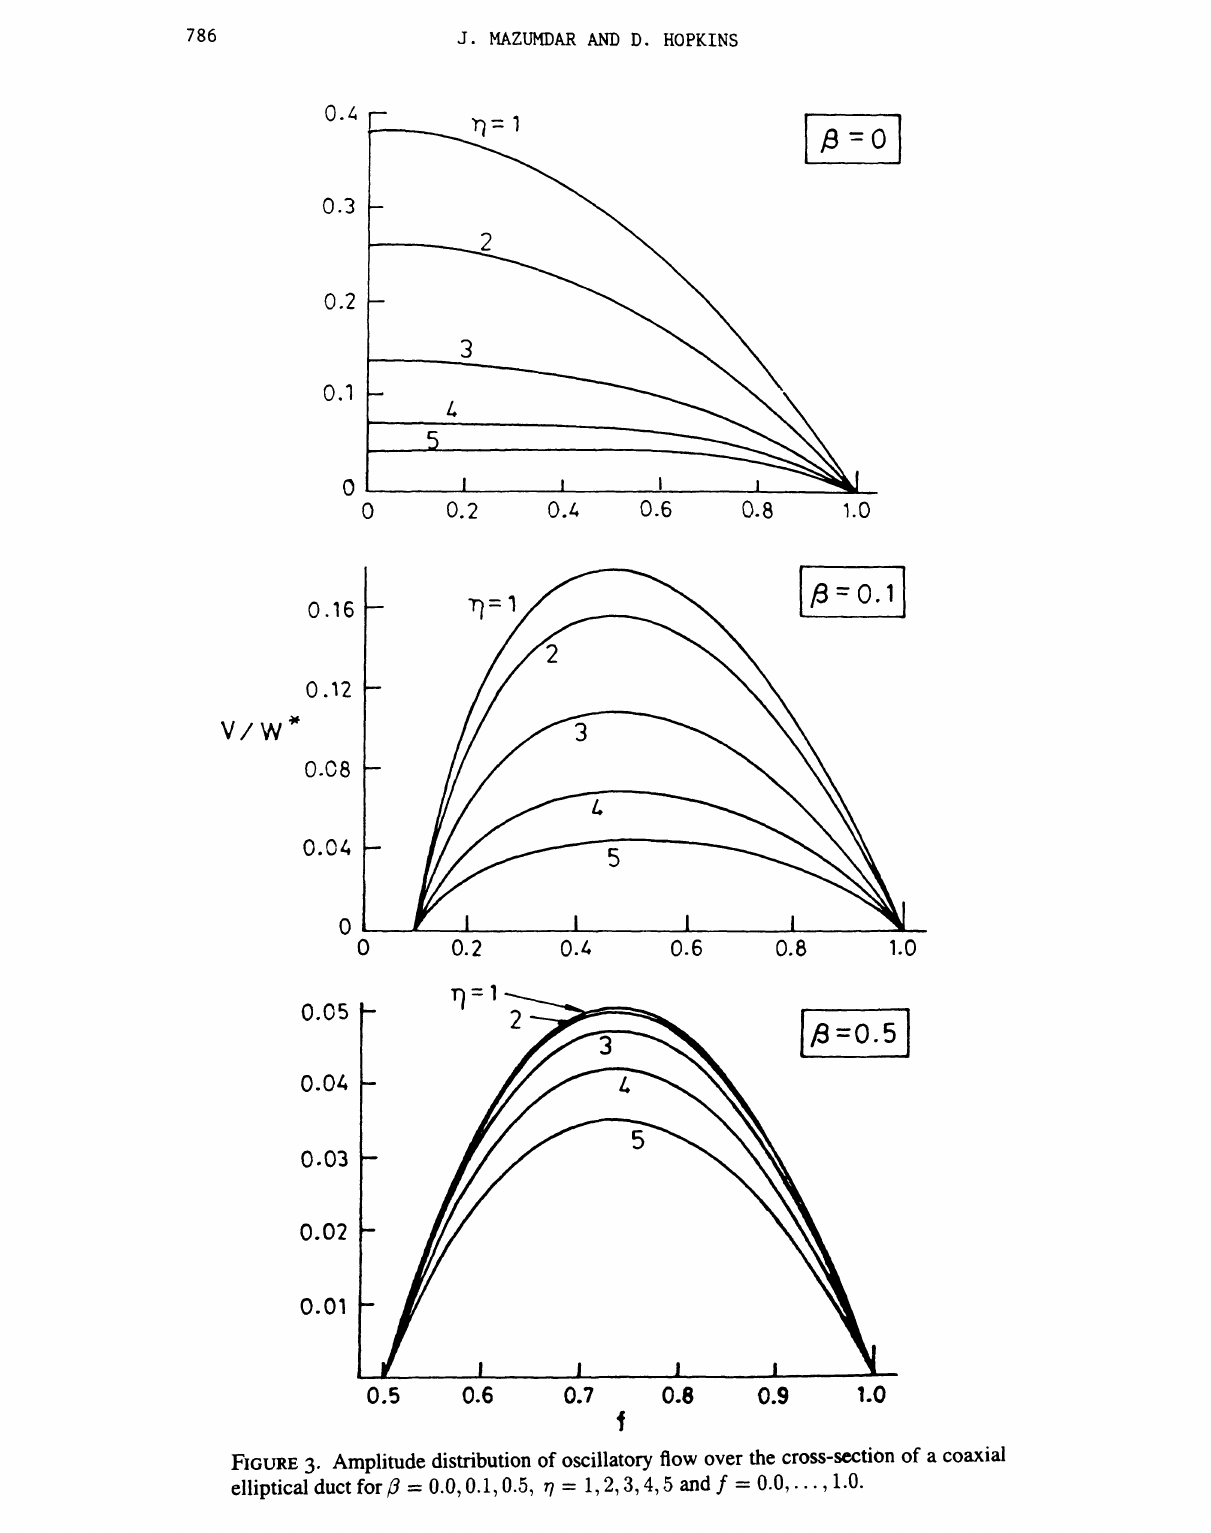
FIGURE 3. Amplitude distribution of oscillatory flow over the cross-section of a coaxial elliptical duct